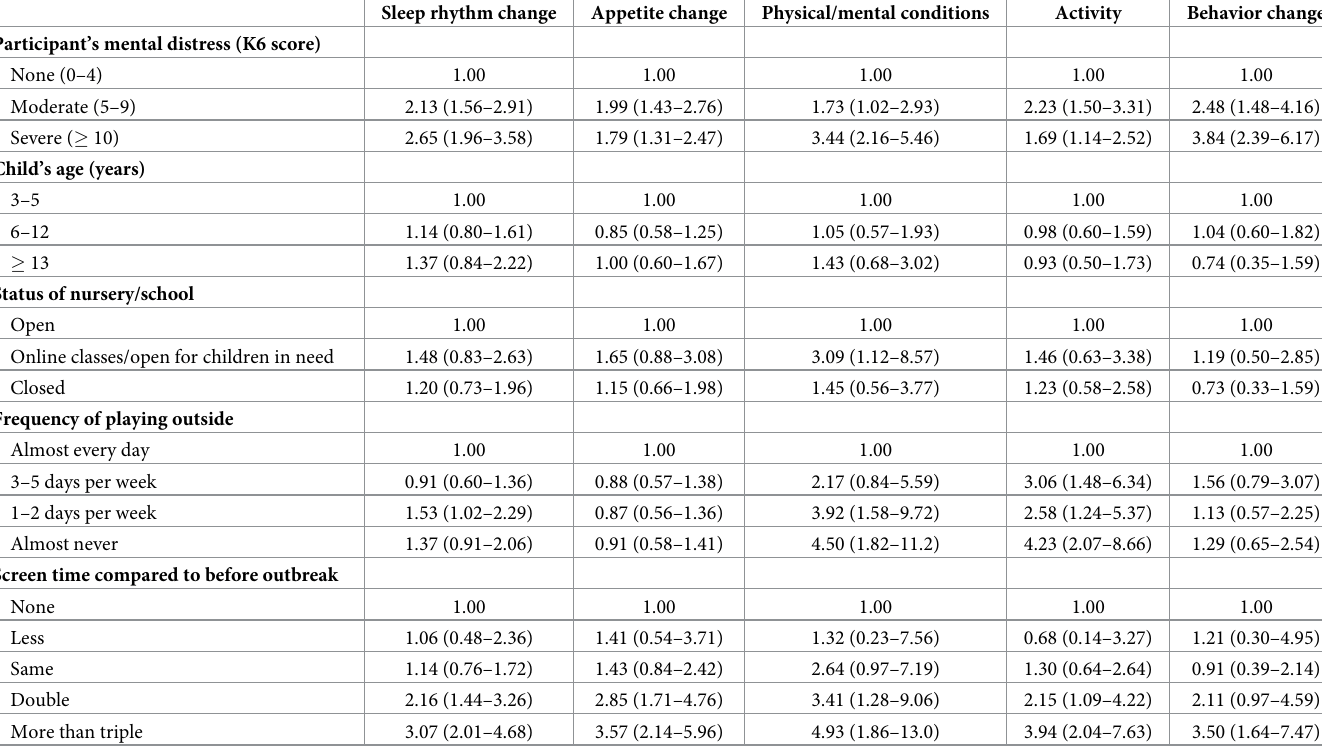
Table 4. Adjusted odds ratios of child health issues by subdomains ( N =